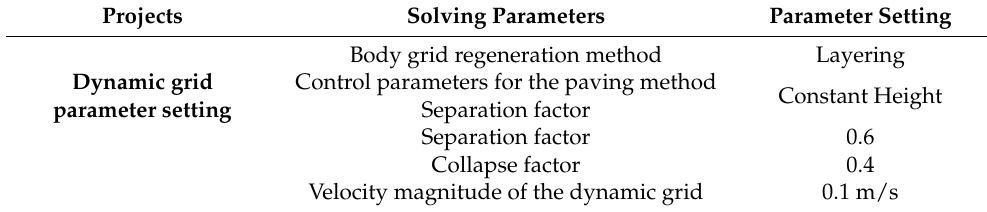
Table 4. Dynamic grid parameter